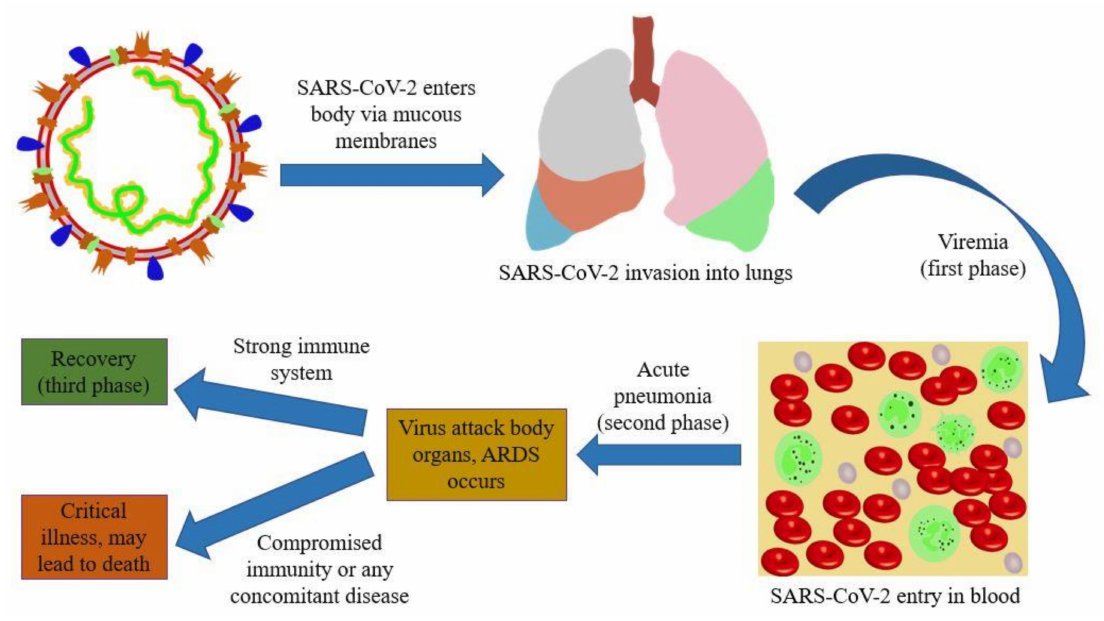
Figure 1. Clinical phases of SARS-CoV-2